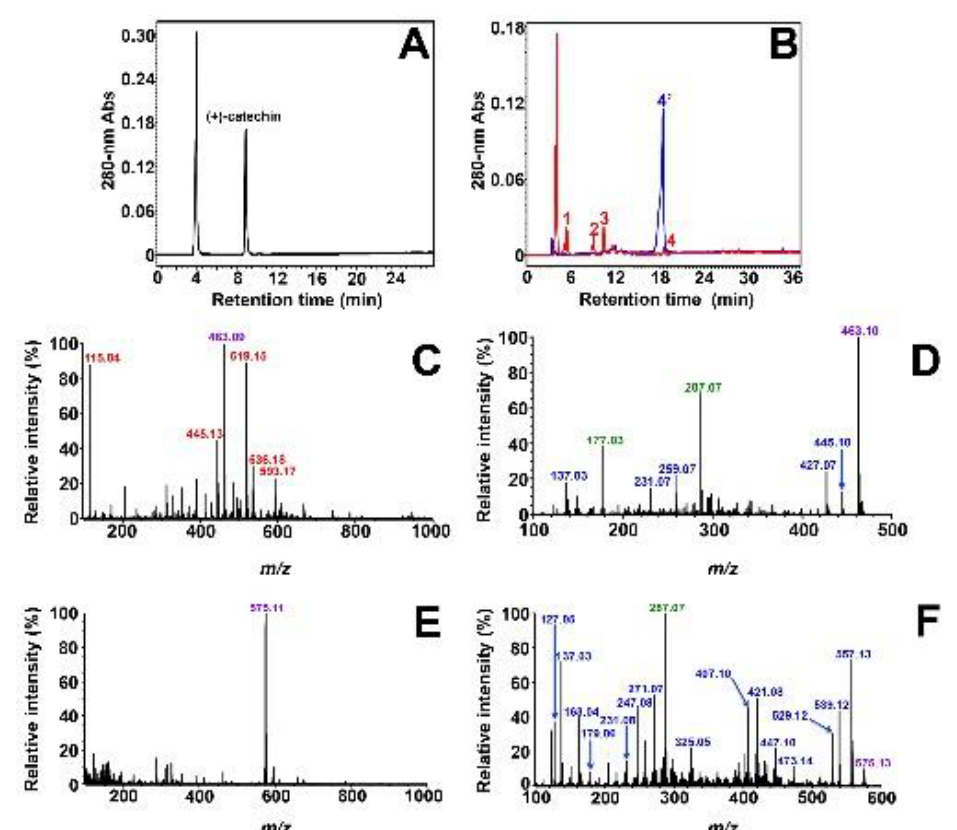
Figure 5. Characterization of Vv ANS product of (+)-catechin. ( A ) Reverse-phase HPLC analysis of the non-enzymatic degradation of 100 µ M (+)-catechin in the reaction mixture without enzyme. (+)-Catechin is eluted at 9.0 min, and no product is observed upon incubation in the absence of Vv ANS. ( B ) HPLC overlay chromatogram of the enzymatic degradation products of (+)-catechin (in red) and the commercial standard of 100 µM cyanidin chloride (in blue). ( C ) MS analysis of collected peak 1. ( D ) MS/MS fragmentation of the [M+H] + ion with m / z 463.09 observed in (C). ( E ) MS analysis of collected peak 3. ( F ) MS/MS fragmentation of the [M+H] + ion with m / z 575.11 observed in ( E ). The two large peaks observed at 4.0 min in ( A , B ) correspond to